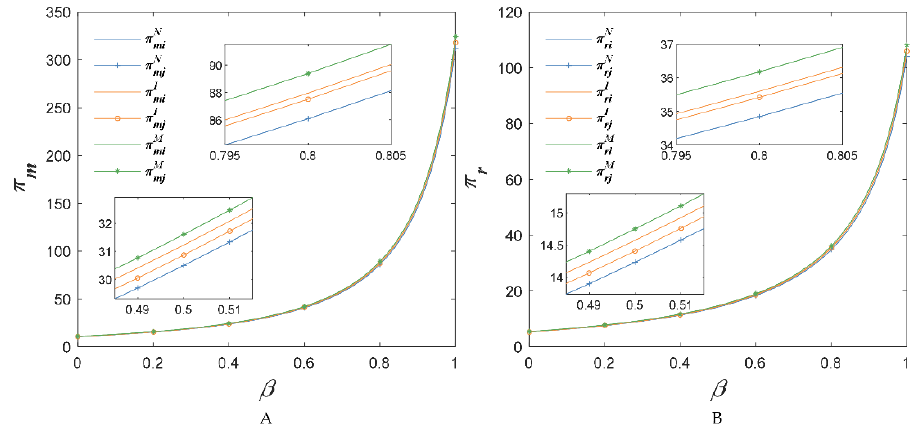
Figure 8. The price sensitivity coefficient of competitive agricultural products’ impact on income of suppliers ( A ) and retailers ( B ), when c om = 0.15, c or =